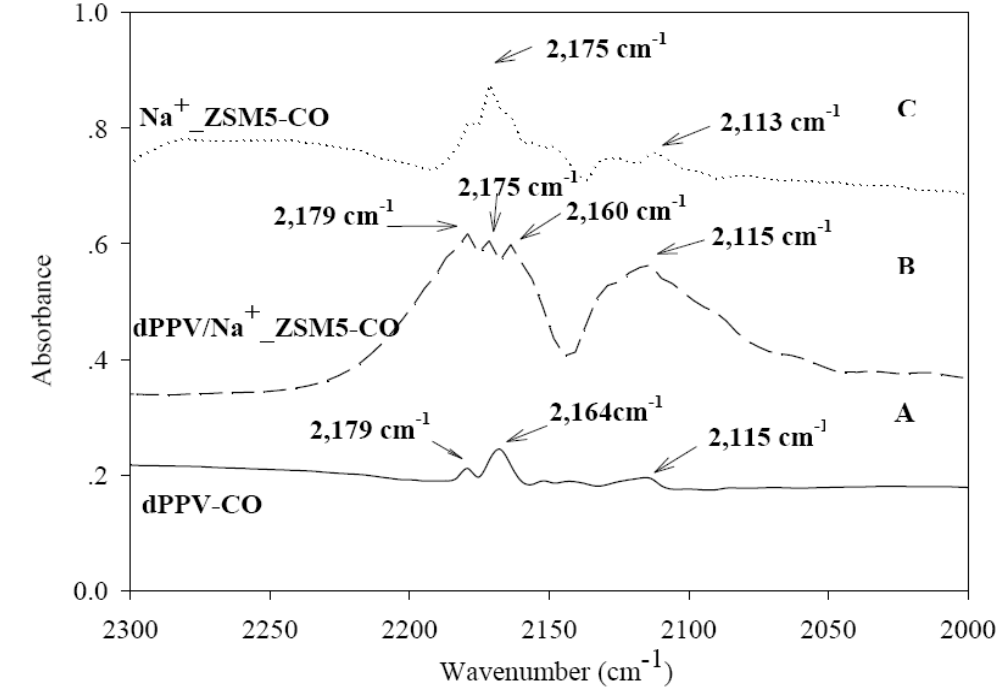
Figure 5. IR spectra of CO (pressure = 1 atm and at room temperature) adsorbed